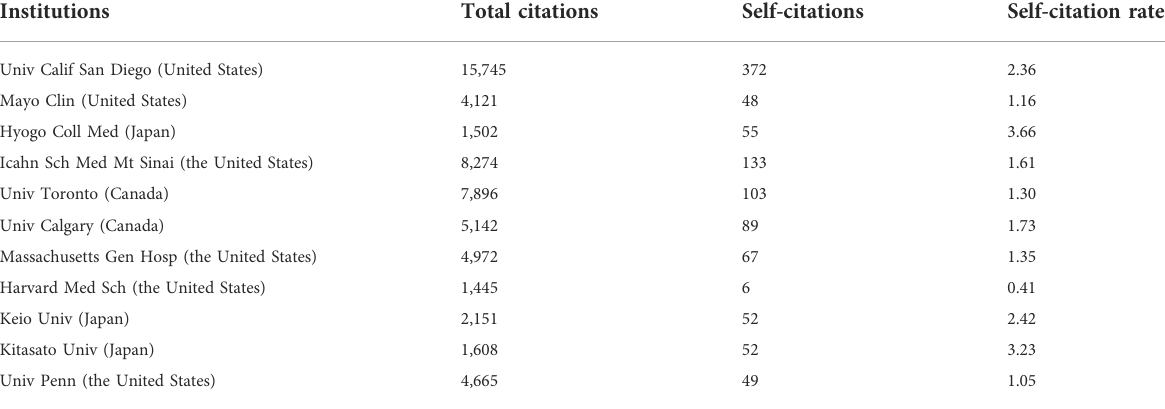
TABLE 2 Self-citations of the top productive institutions involved in UC